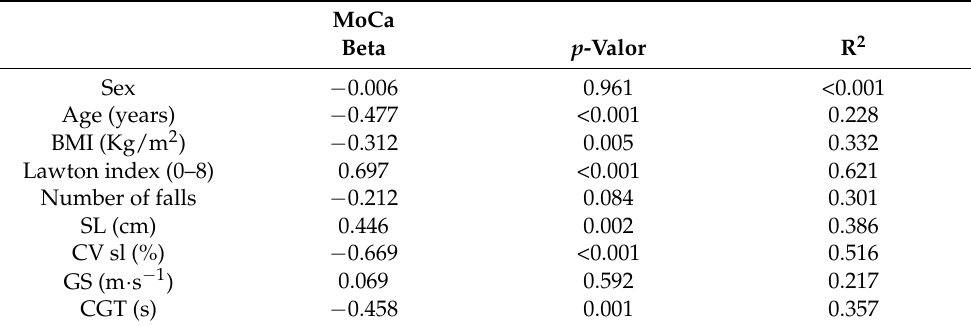
Table 3. Standardized beta coefficients from linear regression models on the associations of age, sex, anthropometric measures, Lawton index, number of falls, and performance in gait tests with MoCA score. MoCa Beta p -Valor R 2 Sex − 0.006